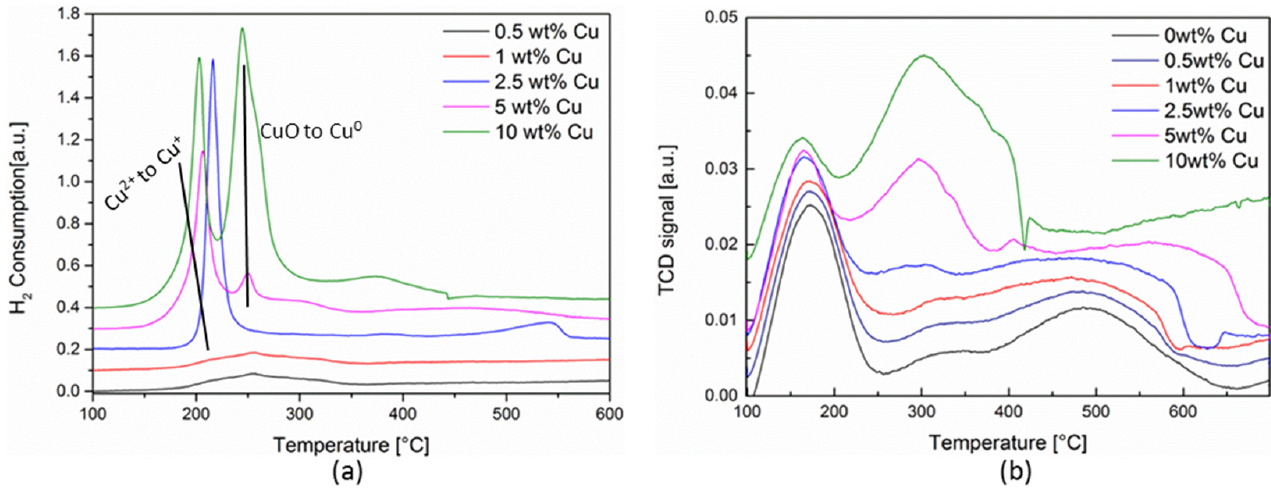
Figure 1. ( a ) Temperature-programmed reduction with hydrogen (H 2 -TPR) of Cu-MORs. ( b ) Ammonia temperature-programmed desorption (NH 3 -TPD) of Cu-MORs.